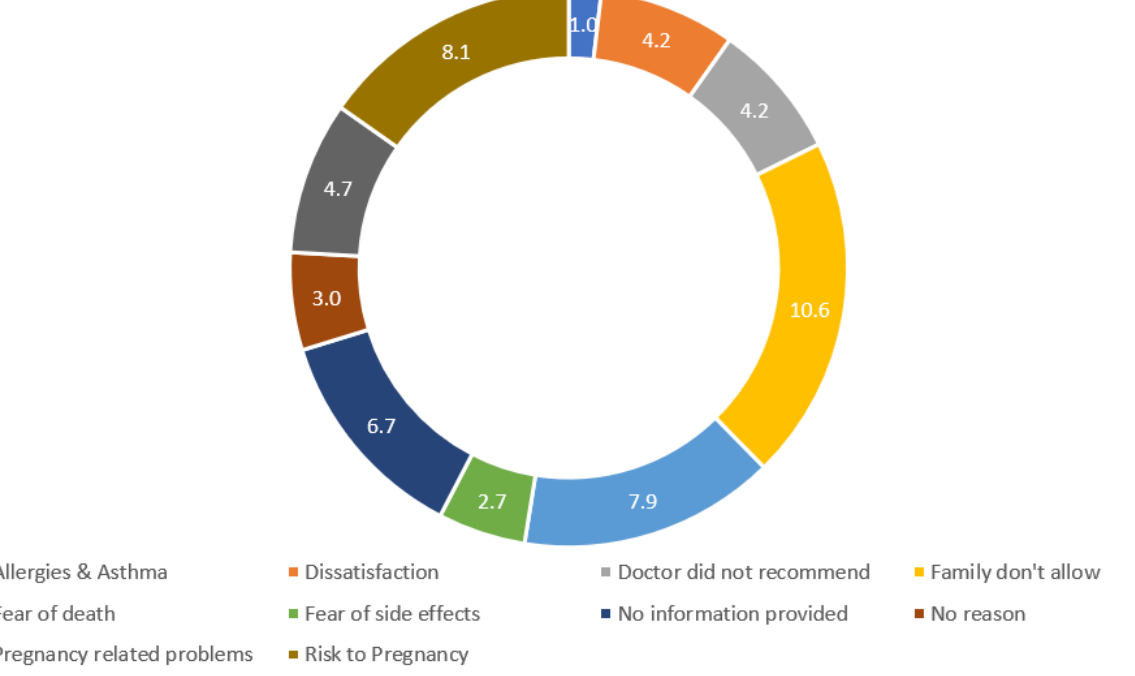
Figure 2. Reasons for not having vaccines in percentage (n = 227). Table 5. Responses to items measuring hesitancy among unvaccinated pregnant women (n =